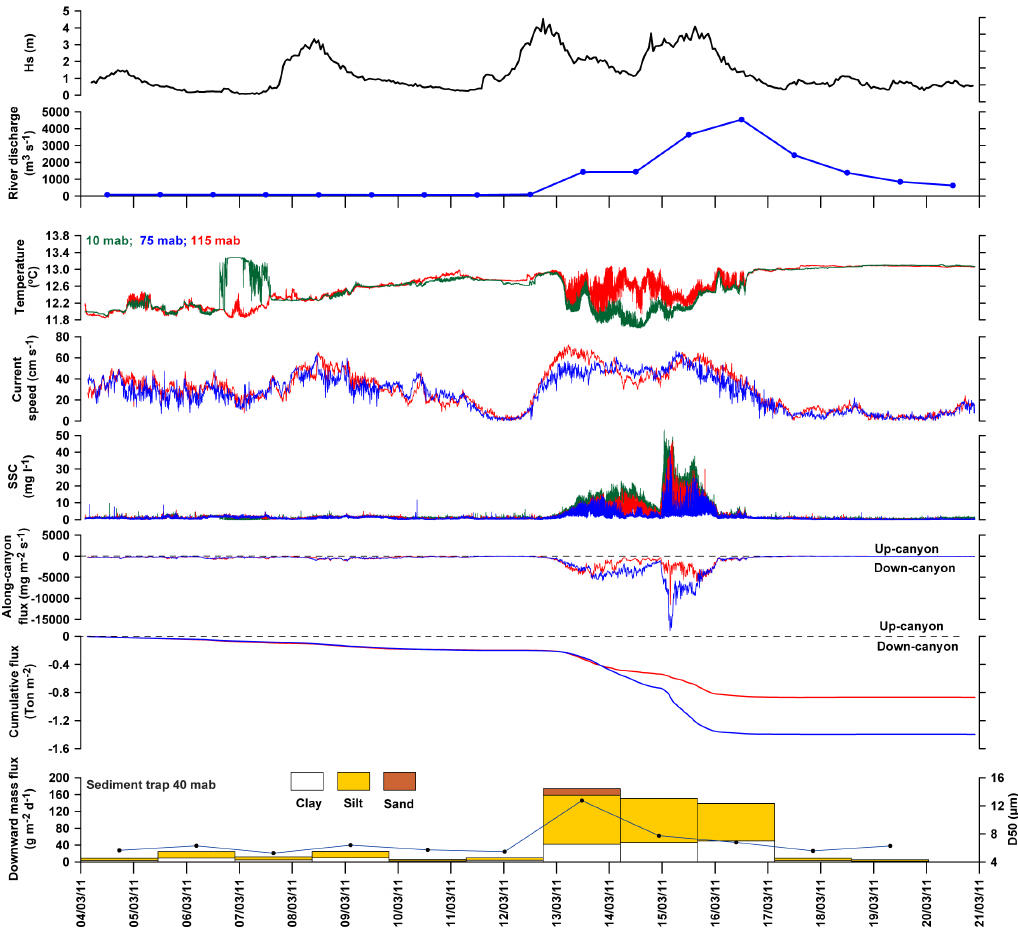
Fig. 7. Time series of water and sediment fluxes in the south flank of the Cap de Creus Canyon (mooring SF1, see Fig. 1b for location). From top to bottom: significant wave height measured at the POEM coastal site; total river discharge from coastal rivers opening to the Gulf of Lion (i.e. excluding the Rhˆone); in situ water temperature (measured by 3 Seapoint Aqualoggers), current speed measured by the ADCP at Seapoint depths, and suspended sediment concentration (Seapoint); along-canyon sediment flux (negative values down-canyon); cumulative transport calculated from the precedent flux; downward mass flux measured by a sediment trap. Trap fluxes are divided in three components according to the major grain-size classes; the median of the grain-size distribution (d50) in sediment trap samples is also